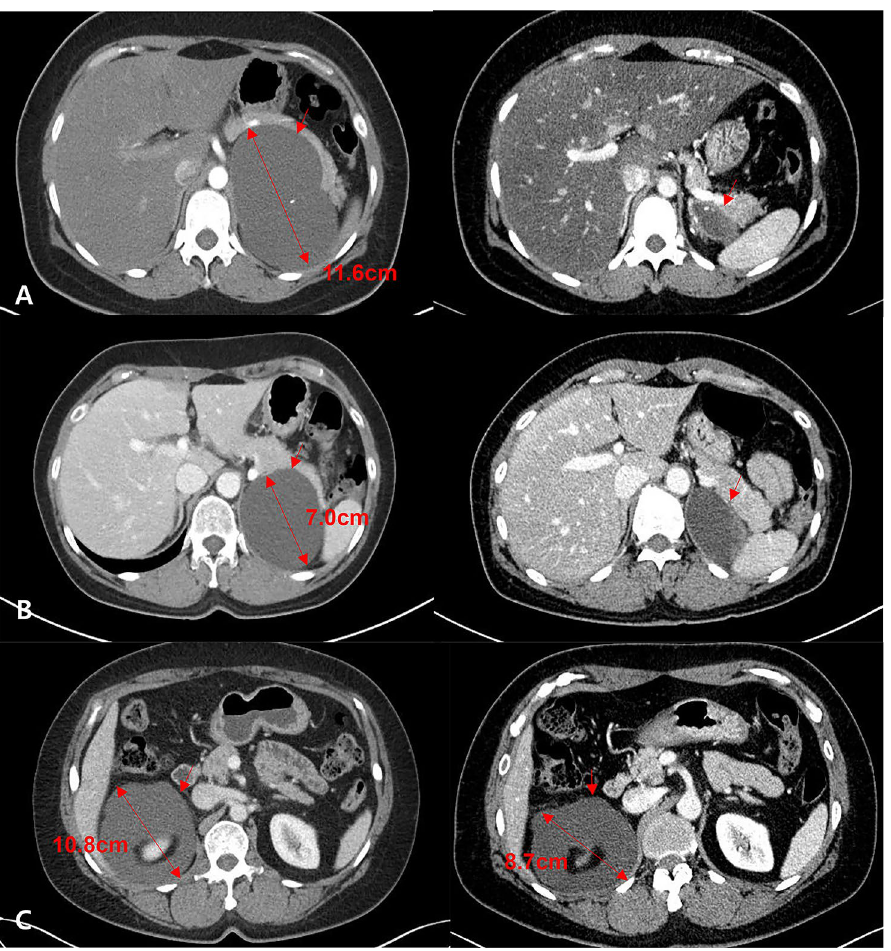
Figure 3. Axial computed tomography (CT) imaging of prior to treatment and 3 months after RFA of ( A ) Patient No. 3, who showed a good response, ( B ) Patient No. 9, who showed an intermediate response, and ( C ) Patient No. 1, who showed a poor response.